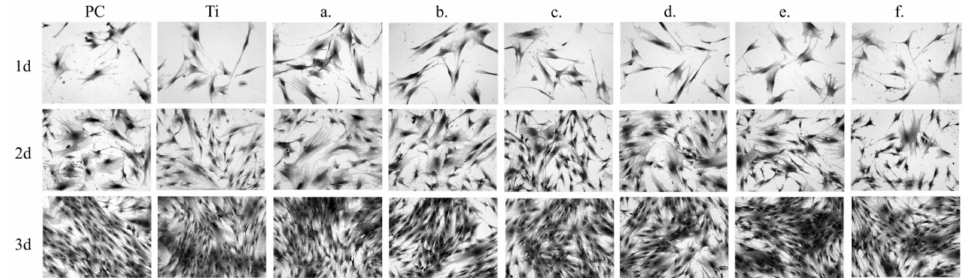
Figure 8. Morphology of the fibroblasts cells cultured for a different time: 24 h, 3 days, and 5 days: Ti31Mo ( a ), Ti31Mo after hydrothermal treatment (HT) ( b ), Ti31Mo5HA ( c ), Ti31Mo5HA1Ag ( d ), Ti31Mo5HA2CeO 2 ( e ), Ti31Mo5HA2Ta 2 O 5 ( f